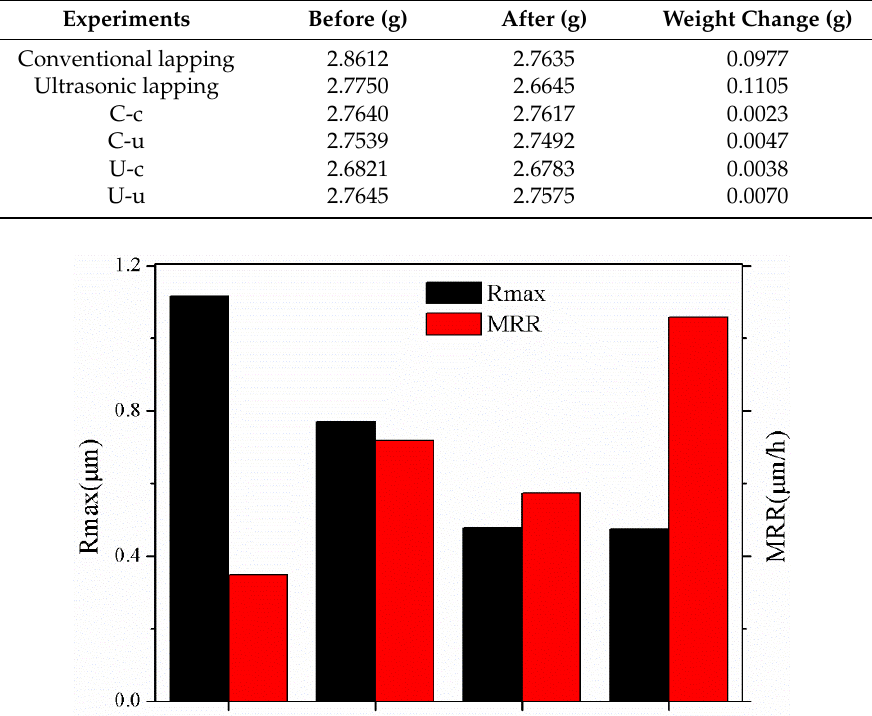
Figure 7. The peak-to-valley value of roughness (Rmax) and material removal rate (MRR) of CMP after lapping.